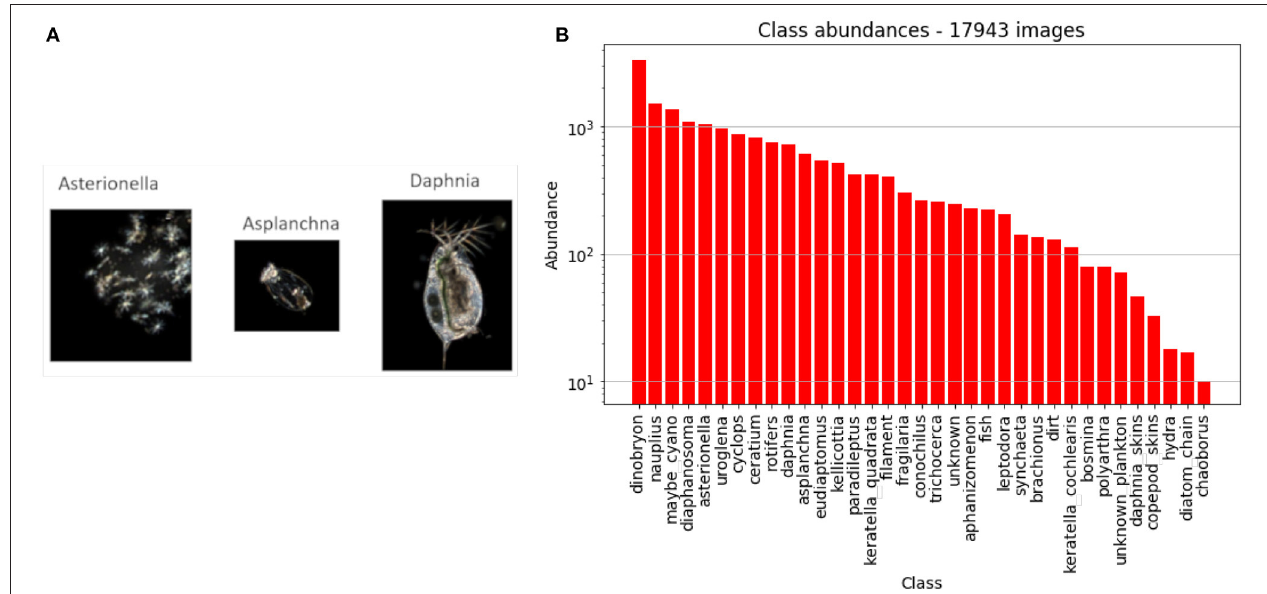
FIGURE 1 | (A) Sample images from the DSPC in Lake Greifensee. (B) Abundance of each class in our dataset. The word class is intended in the classification sense, and does not indicate the taxonomic rank. Note that the y axis has a logarithmic scale.